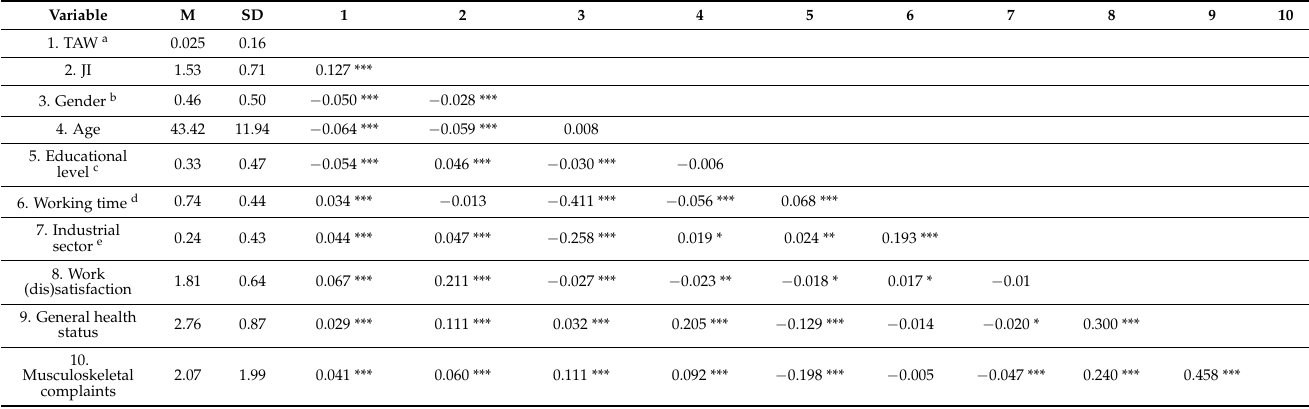
Table 1. Means (M) and Standard Deviations (SD) and Correlations of the Study